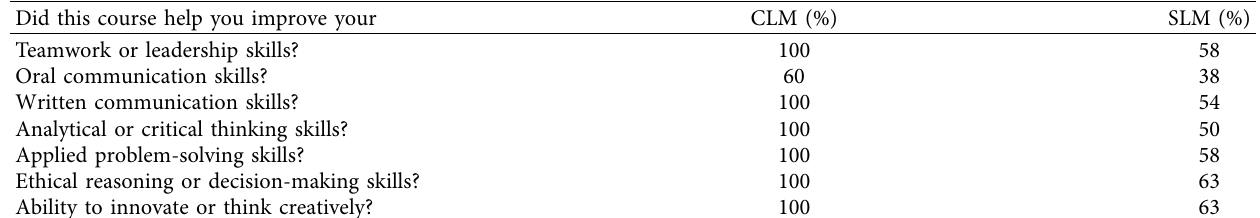
Table 3: Self-perceived improvements in faculty-identified core competencies for student composition.